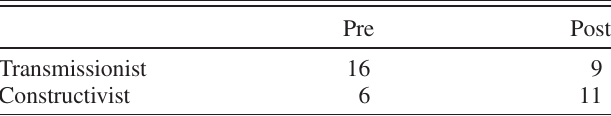
TABLE VI. Categorization of TA writing excerpts into two views of teaching. Columns 2 and 3 indicate categorization by TA for 22 (pre) and 20 (post) TAs.